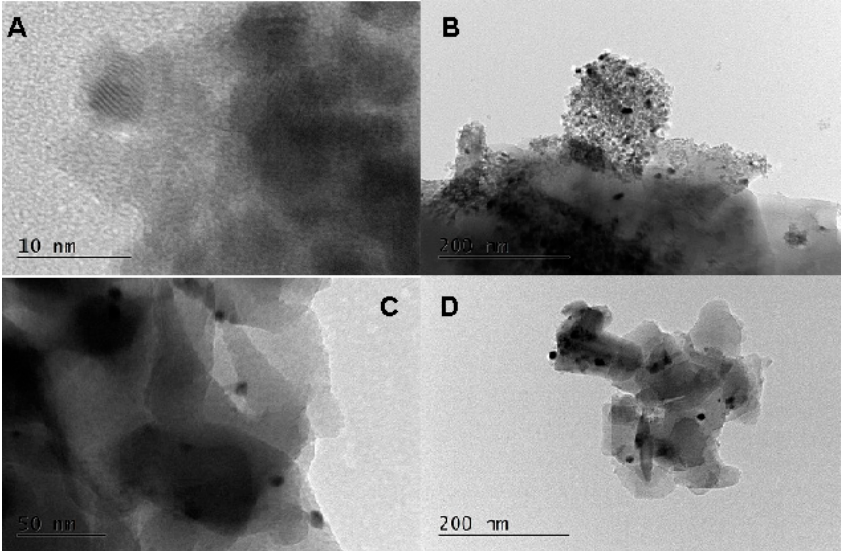
Figure 5. TEM images of 10Ni1Pt/Z-h ( A , B ) and 5Ru1Pt/Z-h ( C , D ) zeolites.